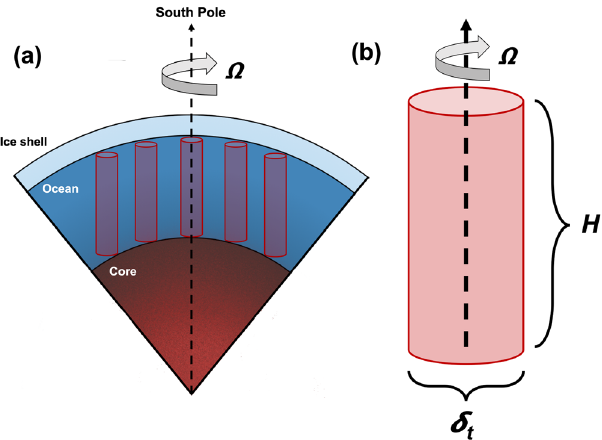
Fig. 1 Rotationally dominated convection columns. a Conceptual representation of rotationally dominated “ Taylor ” convection columns aligned with the axis of rotation within the ocean underneath Enceladus ’ south polar terrain, and b simpli fi ed geometry of one such column. H represents the vertical length of the fl uid system (in this case, the thickness of the ocean), and δ t represent the width of the column and depends on degree of thermal forcing. Not to scale: for a 60 km thick ocean, the Taylor columns are predicted to have widths of δ t ≲ 1.6 km.